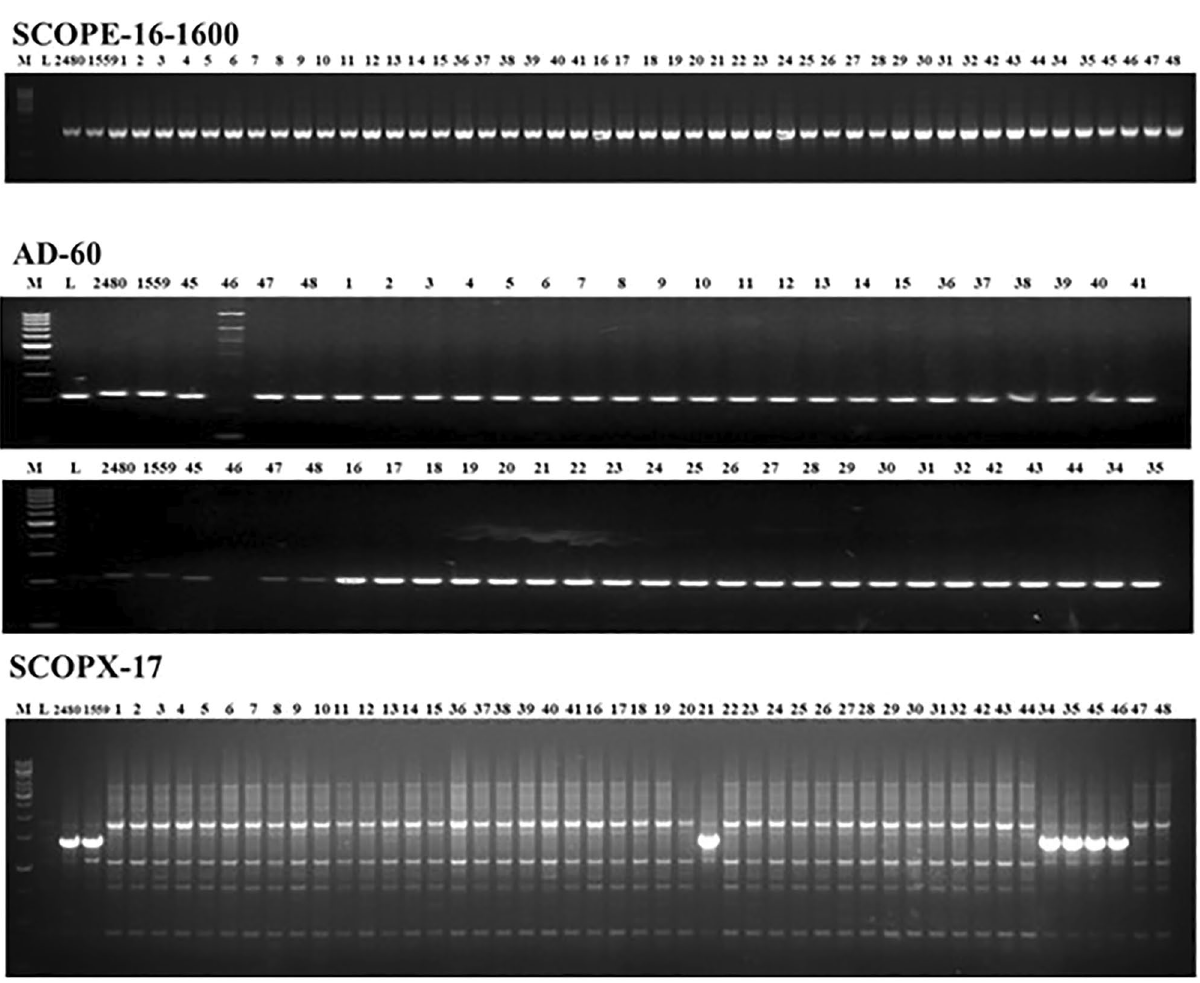
Figure 3. er1 linked markers SCOPE-16-1600 and AD-60 and er2 linked marker SCOPX-17. Legend: M: DNA ladder, L: Lincoln, 2480: er1 harboring line, 1559: er2 harboring line, 1: SP-1, 2: SP-2, 3: SP-3, 4: SP-5, 5: SP-6,